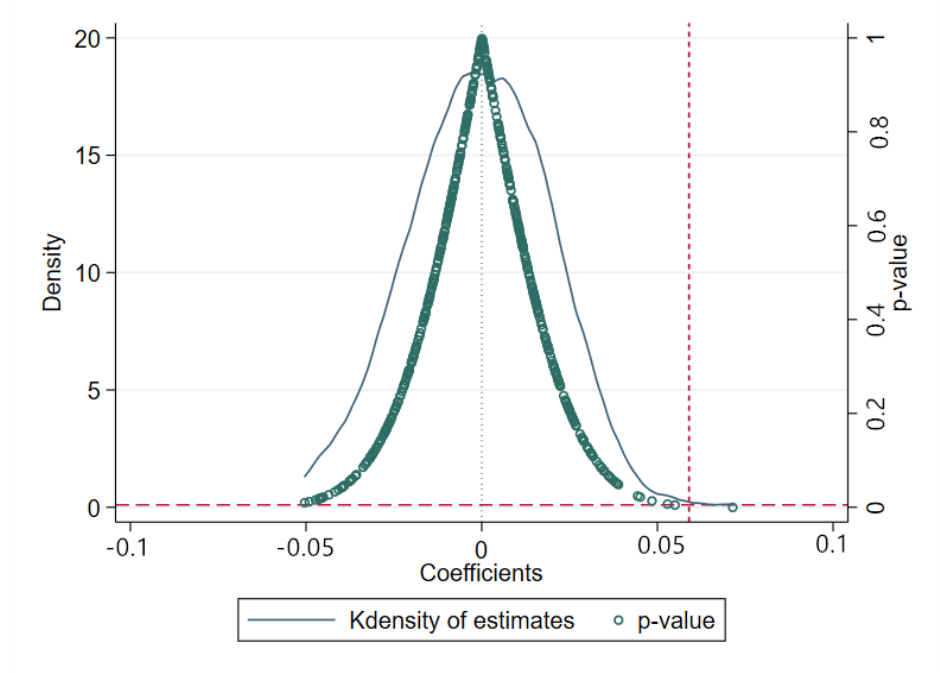
Figure 7. Household technology and child health: placebo test. Table 4. Robustness checks for different indicators and estimation